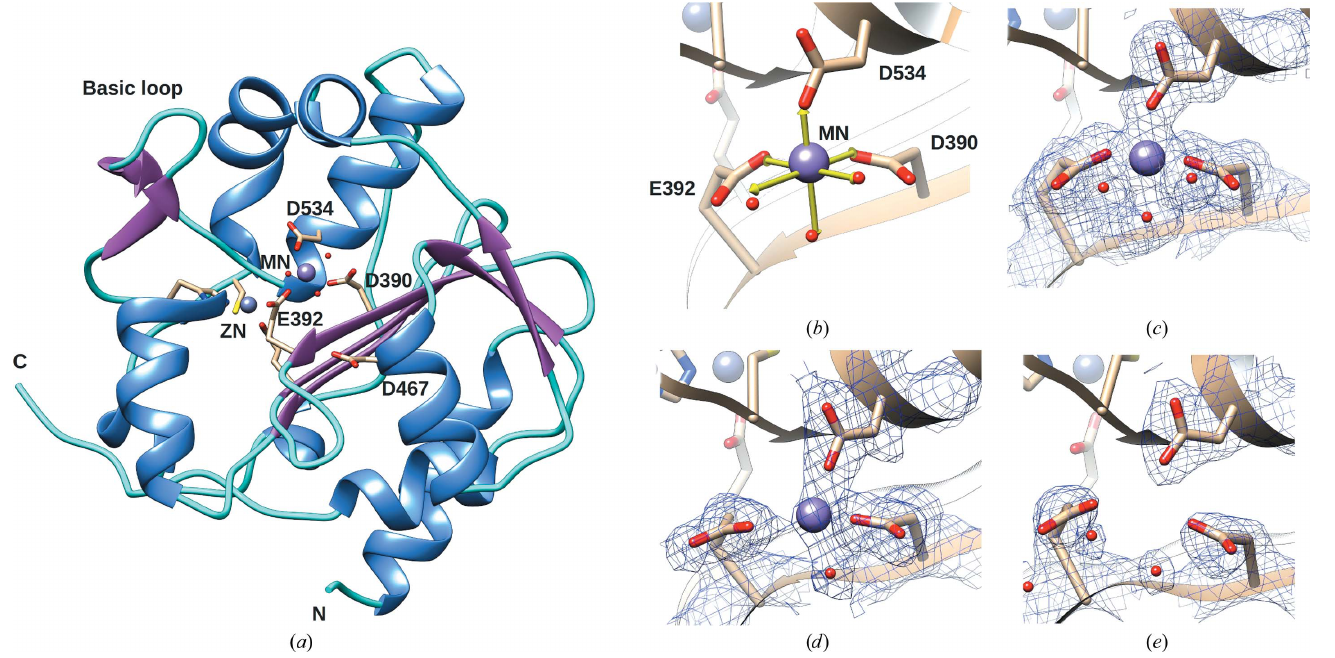
Figure 3 Crystal structure of MOPV NP-exo complexed with Mn 2+ and soaked in the presence of ALD. ( a ) Ribbon representation of MOPV NP-exo complexed with Mn 2+ (PDB entry 6sx8). Mn 2+ is represented as a purple sphere and coordinated by three water molecules (red spheres). The protein structure color code follows that in Fig. 1. Catalytic residues are labeled. Three of the residues coordinating the structural Zn 2+ ion (gray sphere) are also shown, with their side chains in stick representation. ( b ) Enlargement of the Mn 2+ ion in the active site of MOPV NP-exo complexed with Mn 2+ . The theoretical Mn 2+ coordination by the catalytic residues and water molecules is illustrated by yellow arrows. ( c, d , e ) The same view as in ( b ) presenting a 2 F o (cid:4) F c map corresponding to the metal ion-binding site contoured at 1.3 (cid:5) at different soaking times: ( c ) 6 min (PDB entry 6t6l), ( d ) 12 min (PDB entry 6t2a) and ( e ) overnight (PDB entry